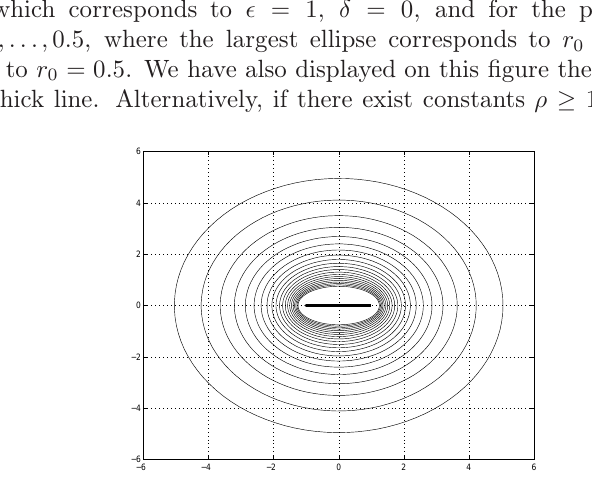
Figure 1. The elliptic regions D 1 , 0 for r 0 = 0 . 1 , 0 . 12 ,..., 0 . 5 ; the interval [ by the thick